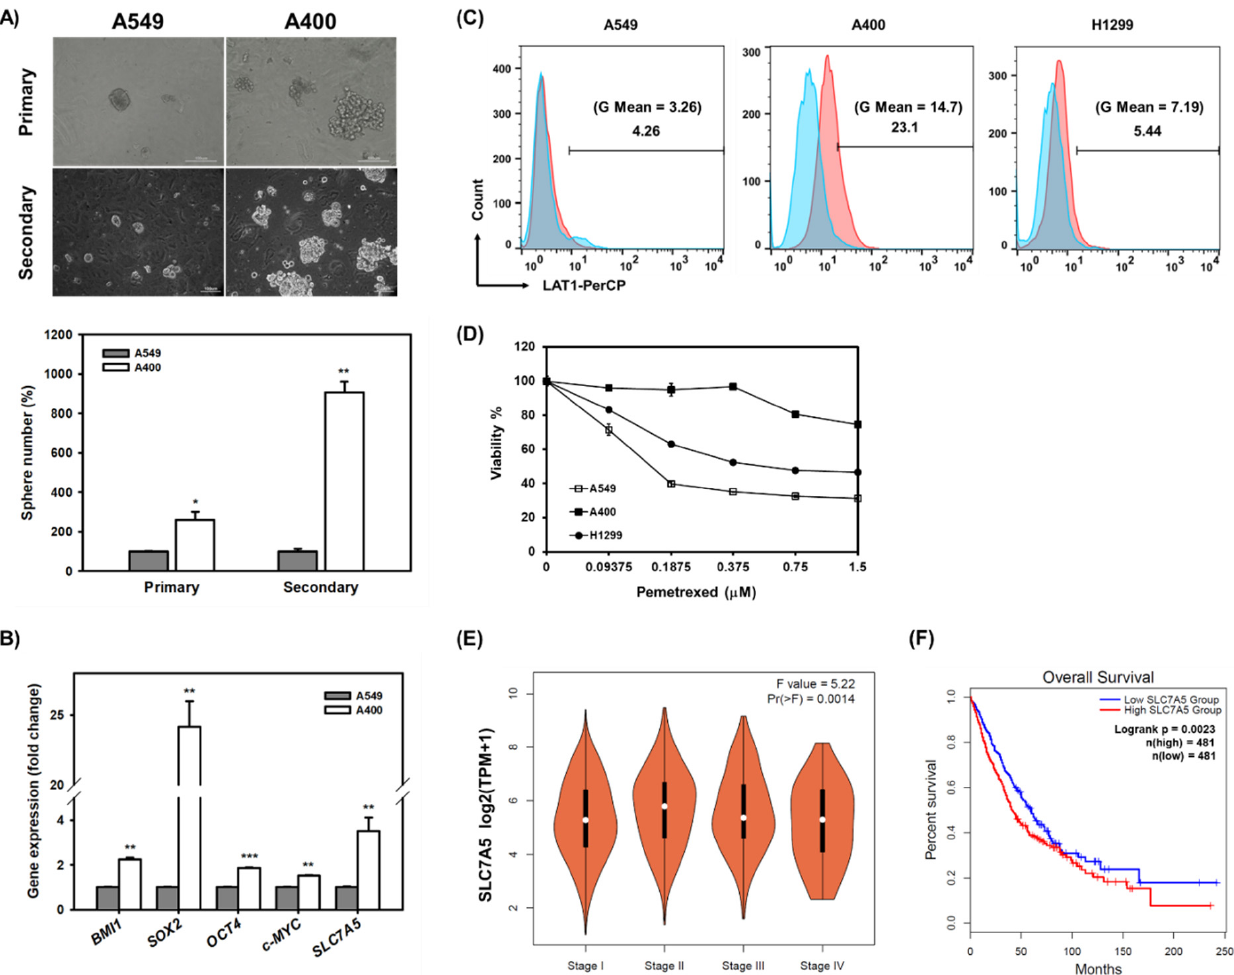
Figure 1. LAT1 expression increases in pemetrexed-resistant NSCLC cells. ( A ) The primary or secondary tumorspheres were cultured from A549 and A400 cells according to the protocol described in the Materials and Methods section. Pictures were presented at 200× magnification. The inserted scale bars indicate 100 μ m in length. Quantitative data were presented as the related percentage to the tumorsphere number of A549 cells. * p < 0.05; ** p < 0.01. ( B ) The mRNA expressions of cancer stemness genes (BMI1/SOX2/Oct4/c-Myc) and SLC7A5 in A549 and A400 cells were determined by real-time RT-